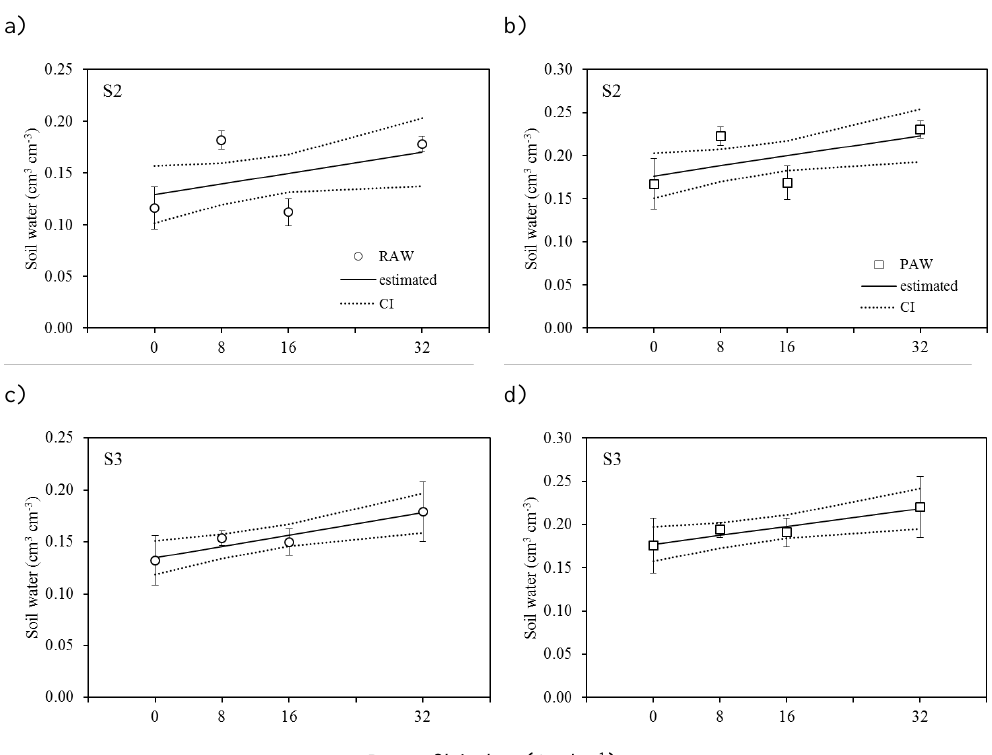
Figure 5. Rice-available water ( (cid:13) RAW: ˆ θ 6 − ˆ θ 100 ) and plant-available water ( (cid:3) PAW: ˆ θ 6 − ˆ θ 1500 ) in the upper 5–10cm layer of a sandy Dystric Plinthosol at 2 (S2 – a, b ) and 3 (S3 – c, d ) years after application of biochar rate (0, 8, 16 and 32Mgha − 1 ) . Symbols represent means and error bars represent standard deviation ( n = 4). Solid lines represent estimated responses to biochar rate with respective 95% confidence intervals (CI, dotted lines). Parameter estimates of fitted linear models are presented in Table 2.